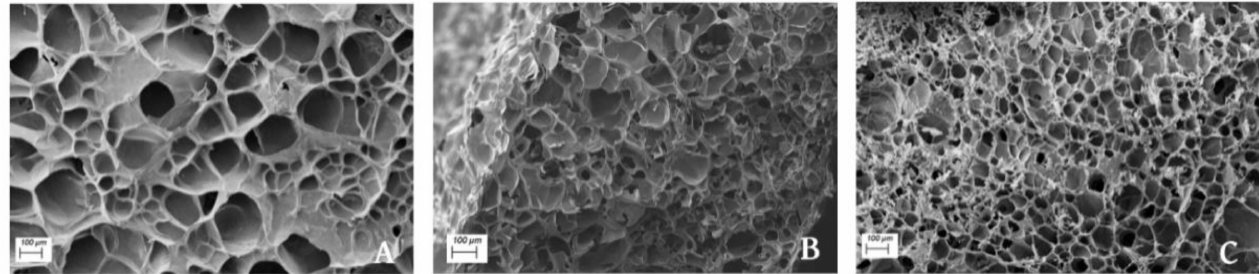
Figure 8. SEM micrographs of matrices obtained after swelling and freeze-drying of injection-molded reference ( A ), FD ( B ), and SFD ( C ) porcine plasma protein